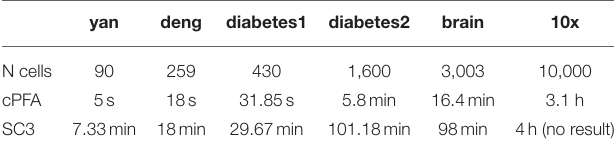
TABLE 2 | The running time compared with SC3 on real datasets.